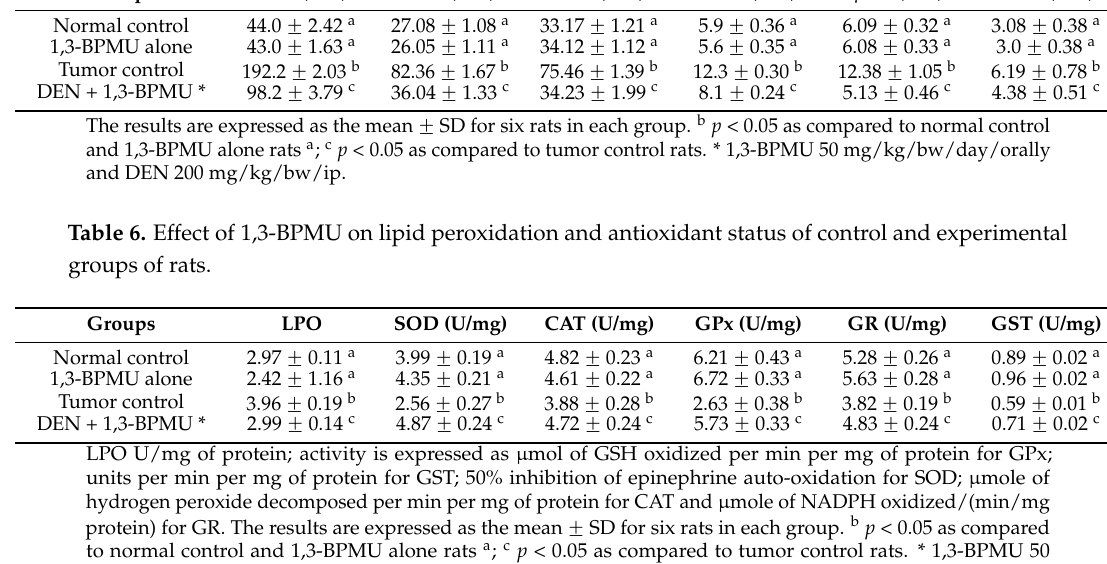
Table 5. Effects of 1,3-BPMU on serum marker enzymes of control and experimental rat groups. Groups